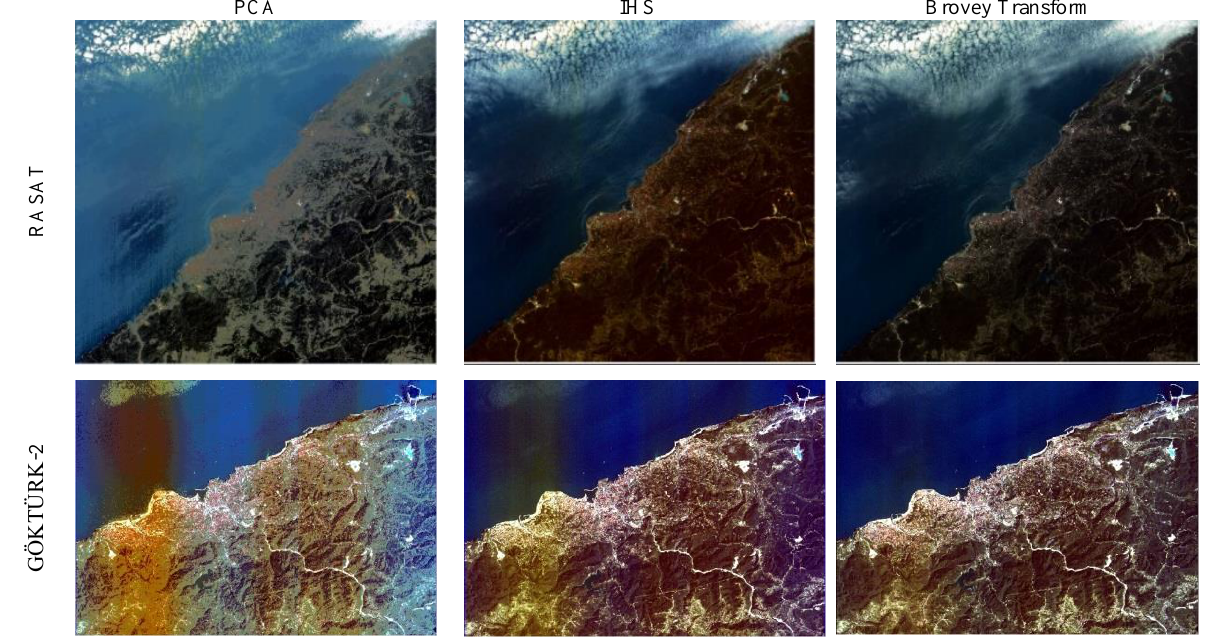
Figure 3. Pan-sharpened images. RASAT pan-sharpened images (1 st row). GÖKTÜRK-2 pan-sharpened images (2 nd